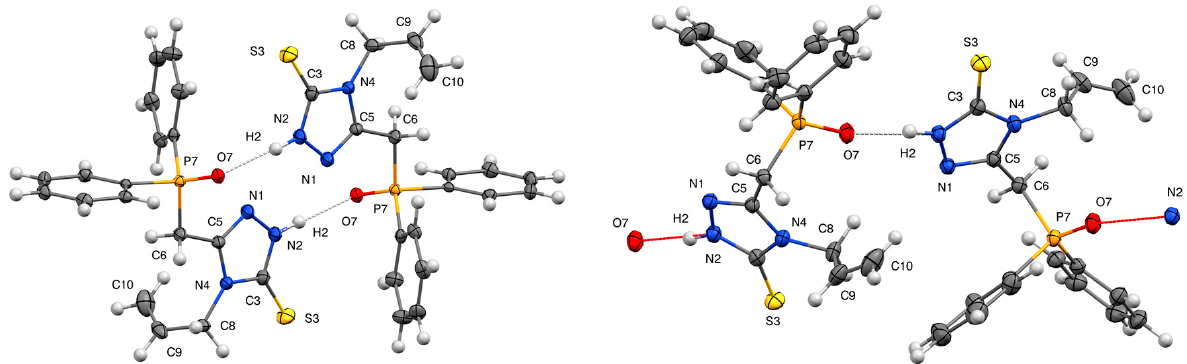
Table 3. Geometrical parameters and characteristics of ρ (r) in BCPs for intermolecular H-bonds in polymorphs 1a and 1b .